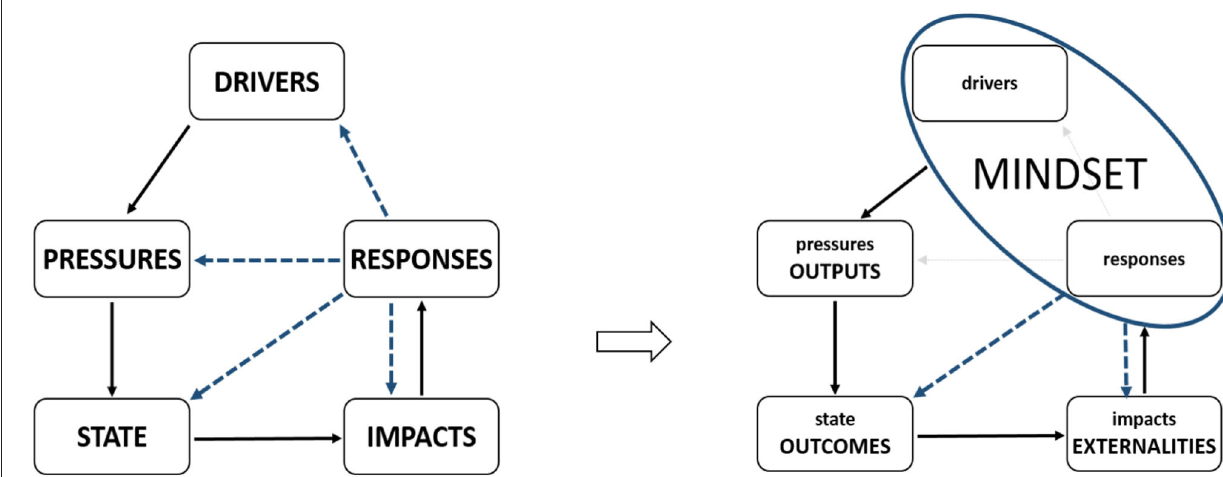
FIGURE 2 | Original vs. modified DPSIR framework.